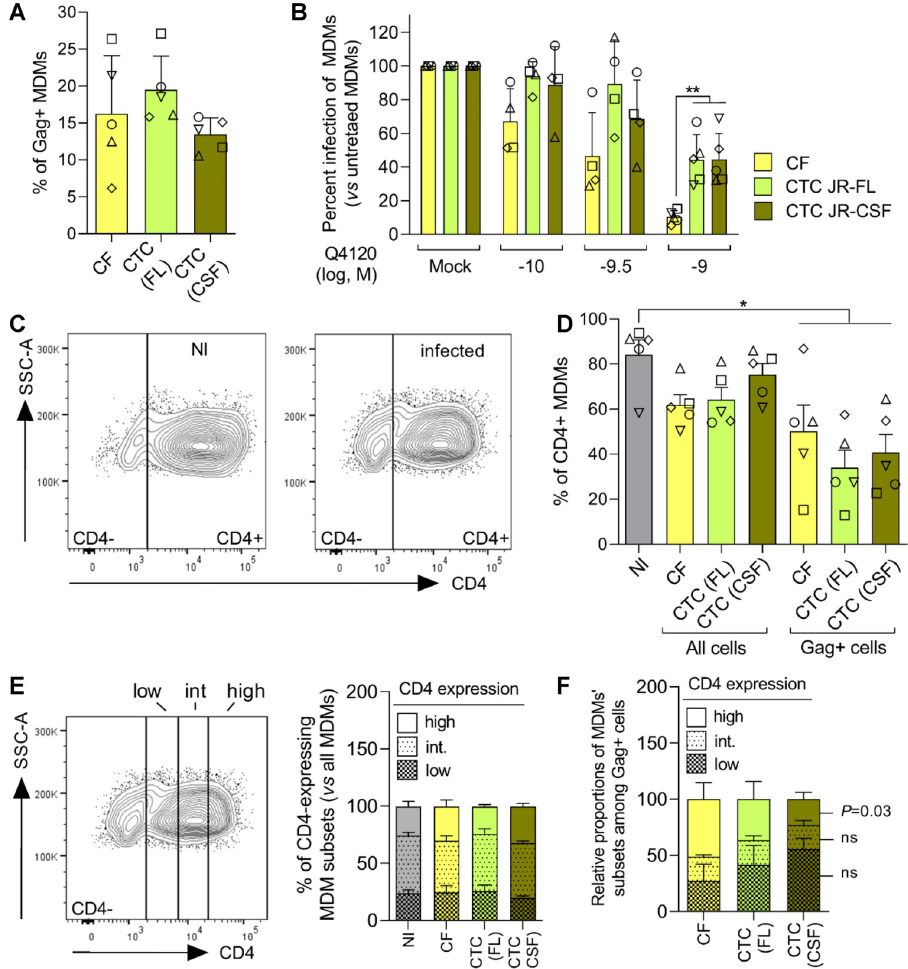
Fig 6. Increased efficiency of CD4 use in HIV-1 transfer between infected T cells and MDMs. A) The experiments analyzing CD4 dependence were performed with similar proportion of Gag+ MDMs exposed to cell-free (CF) JR-FL Env-pseudotyped viruses or Jurkat cells infected with JR-FL (FL) or JR-CSF (CSF) Env-pseudotyped viruses (CTC). B) Dose-dependent inhibition by Q4120 of CTC or CF MDM infection, carried out as described in the experimental scheme of Fig 5A . Error bars: SD. C) Representative flow cytometry plots of cell side scatter as a function of CD4 expression level at the surface of untreated (NI) or virus-exposed (infected) MDMs. D) Proportions of CD4+ cells within untreated MDMs (NI), or MDMs exposed to infected Jurkat cells (CTC) or cell-free viruses (CF). In the latter case, results were analyzed for all MDMs (Gag- and Gag+ cells) or among Gag+ MDMs only. Results are means ± SEM of 5 independent experiments. E) The left panel represents the gating strategy of MDMs expressing low, intermediate or high levels of CD4, after cell-to-cell (CTC) or cell-free (CF) infection in the absence of inhibitor, as detailed above. CD4 expression level was determined using a BV786-conjugated anti-CD4 mAb on a BD Fortessa flow cytometer. Right panel: Relative proportions of MDM subsets expressing low, intermediate or high levels of CD4 among all MDMs exposed, or not (NI), to infected Jurkat cells (CTC) or to cell-free viruses (CF). F) Relative proportions of MDMs expressing low, intermediate or high levels of CD4 among total Gag+ MDMs after CTC or CF infection. Statistics: Mann-Whitney U-test; � , P < .05; ns: not